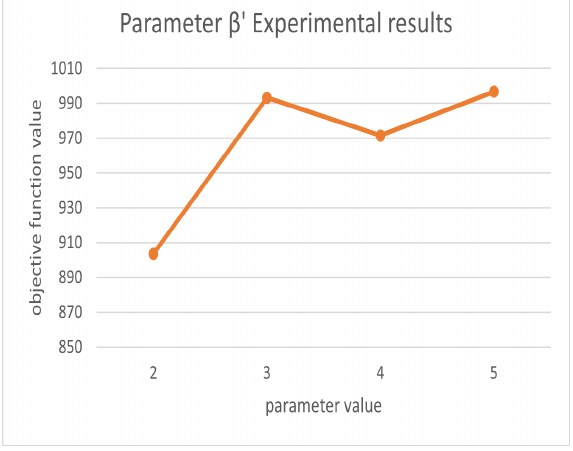
Figure 7. Experimental results for parameter β (cid:48) .